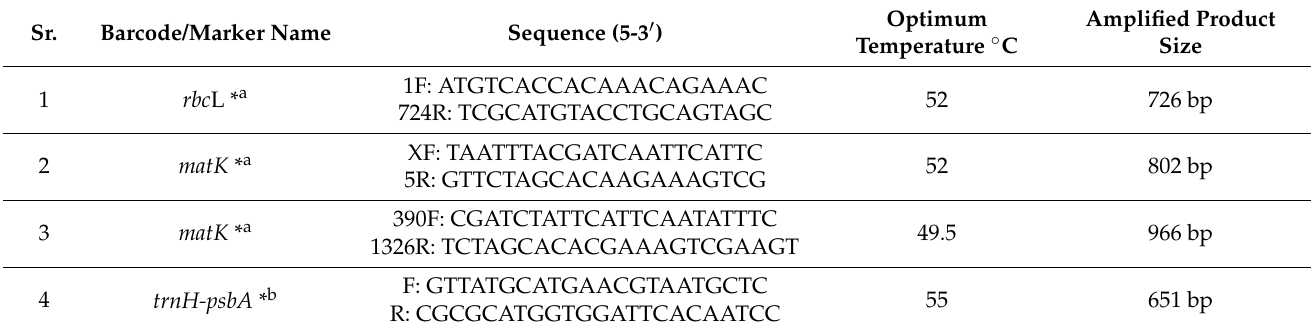
Table 1. List of barcoding genes used for Polymerase Chain Reaction (PCR) and sequencing with experimentally optimized amplification temperature.